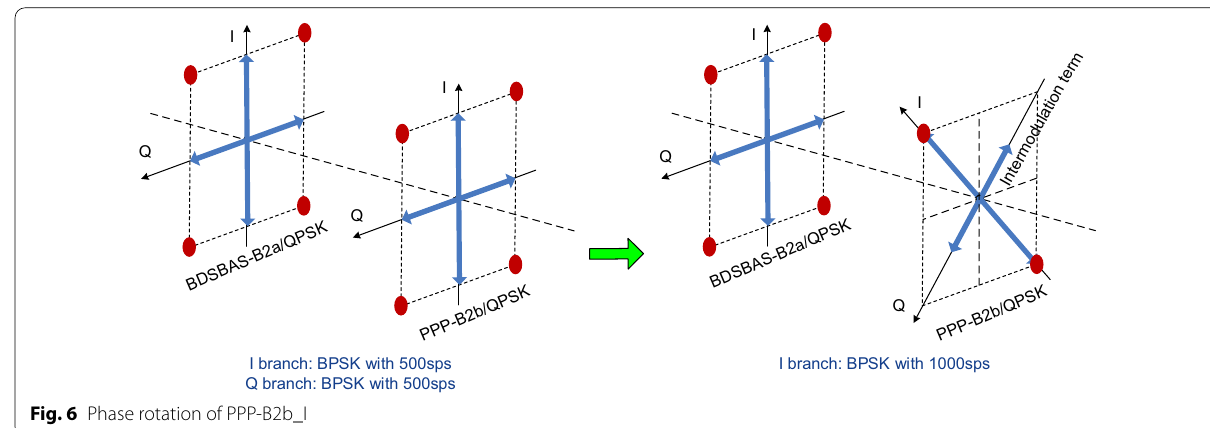
Fig. 6 Phase rotation of PPP-B2b_I